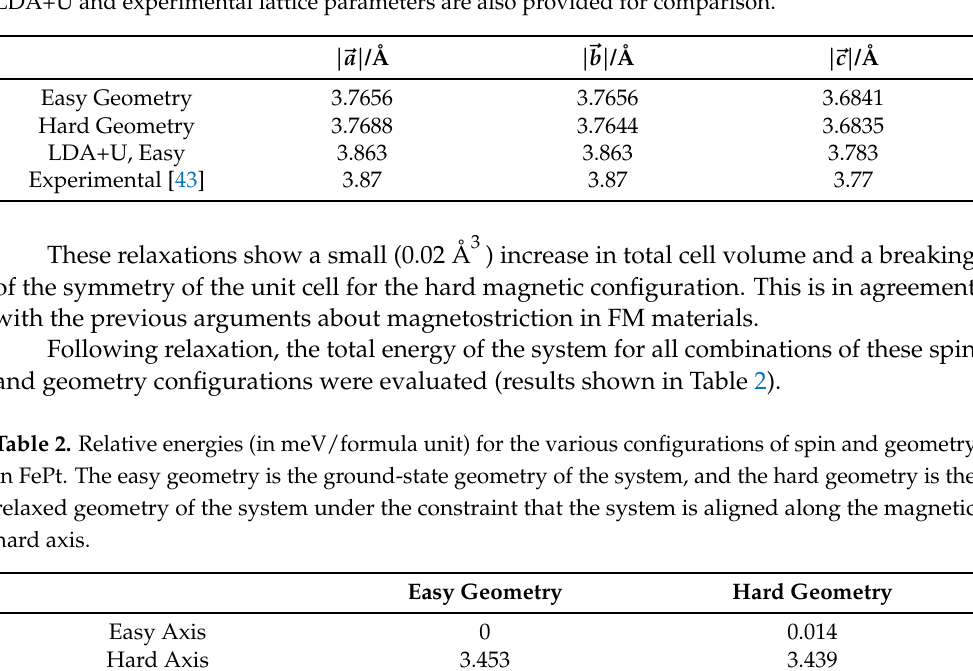
Table 1. Lattice parameters for relaxed PtMn dependant upon the different spin configurations. LDA+U and experimental lattice parameters are also provided for comparison.